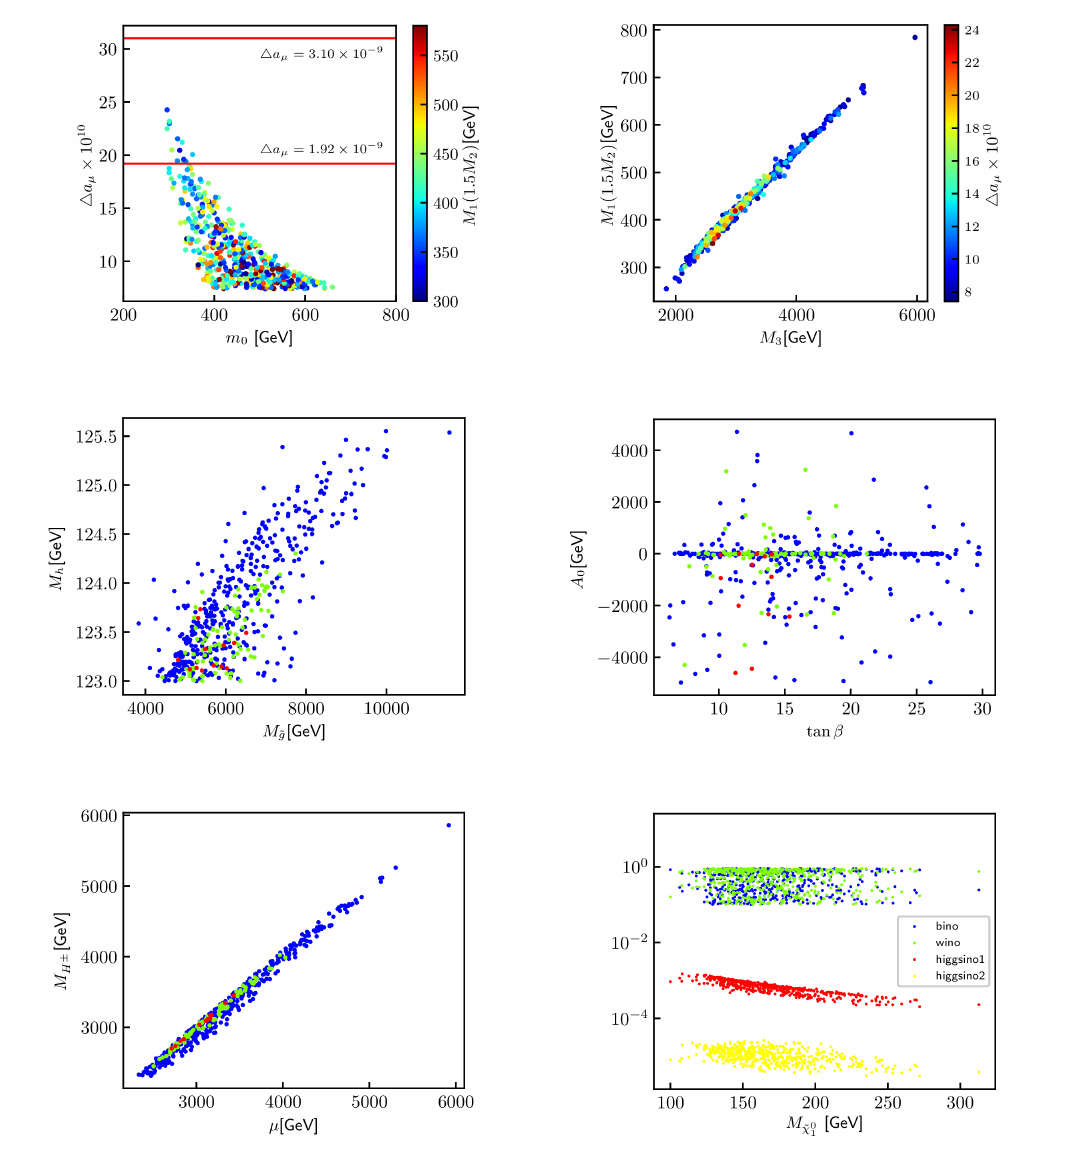
Figure 6 . Survived points in scenario (3) that can satisfy the constraints from (i–vi) and give SUSY contributions to ∆ a up to the 1 σ range of ∆ a combine . In the middle and lower panels, the µ µ red, green and blue points denote the survived samples that can give ∆ a SUSY above the 1 σ , 2 σ and µ 3 σ bounds,